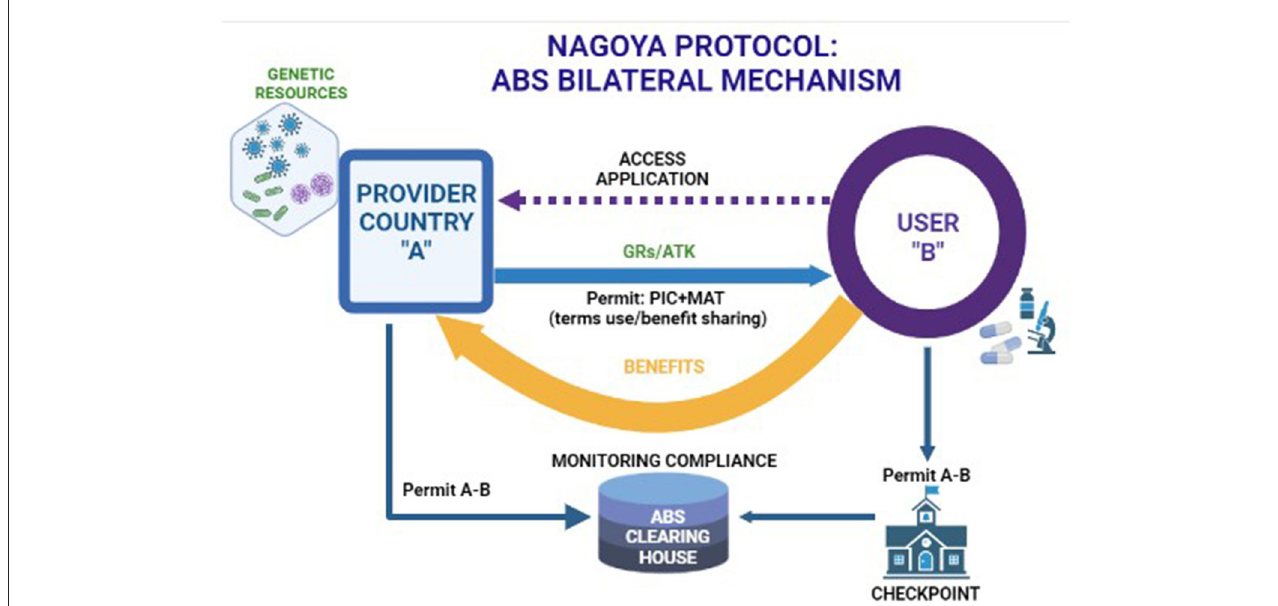
FIGURE1 The ABS bilateral mechanism of the Nagoya Protocol. Created in Biorender.com accessed on 28th December